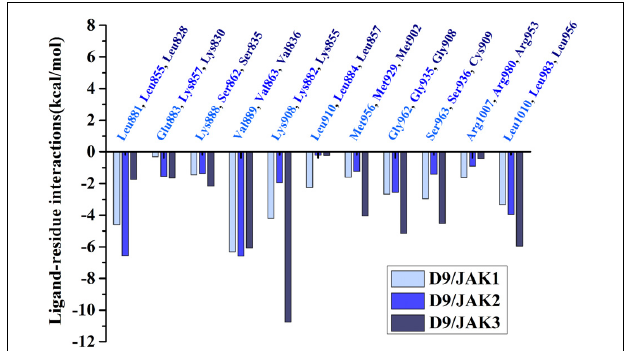
FIGURE 6 | Comparison of energy contributions of the important corresponding residues for the D9/JAK1 (wathet), D9/JAK2 (blue), D9/JAK3